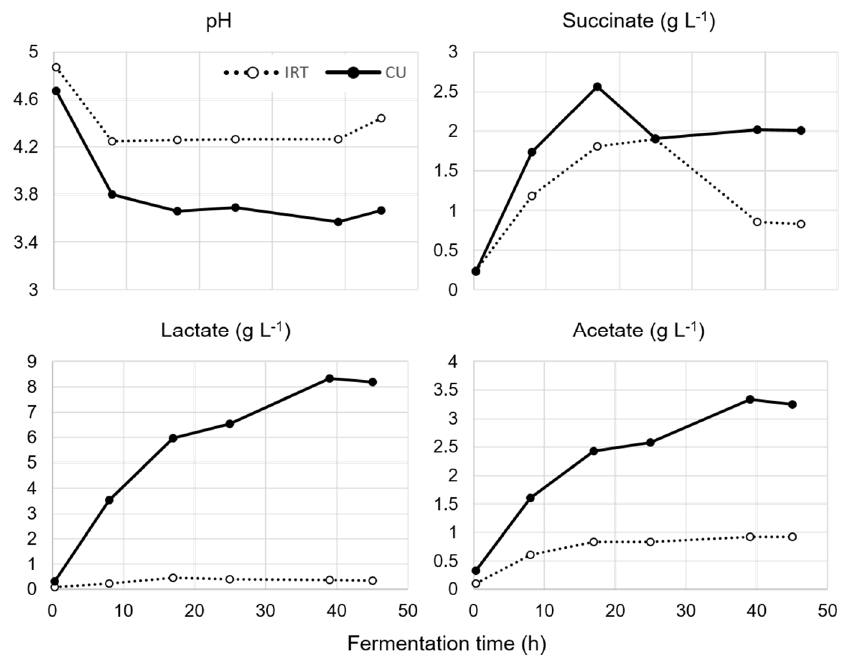
Figure 3. pH, succinate, lactate, and acetate contents for both treatments (IRT—ionizing radiation treated; CU—contaminated untreated) at different fermentation times in Study 2.